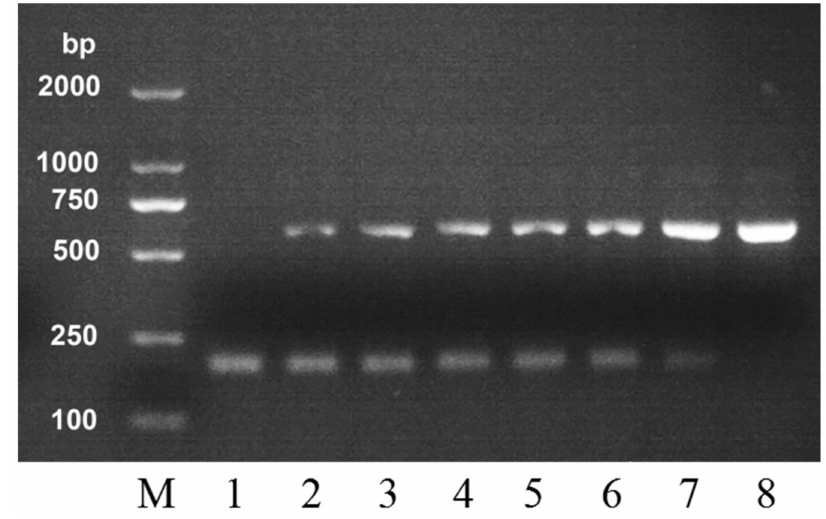
Figure 3. Agarose gel electrophoresis of DNA amplified from genomic DNA extracts of the mixtures of A. cerana honey and A. mellifera honey in duplex PCR. Lane M, DNA marker. From left to right, the proportion of A. mellifera honey was 0, 1, 5, 10, 30, 50, 80, and 100